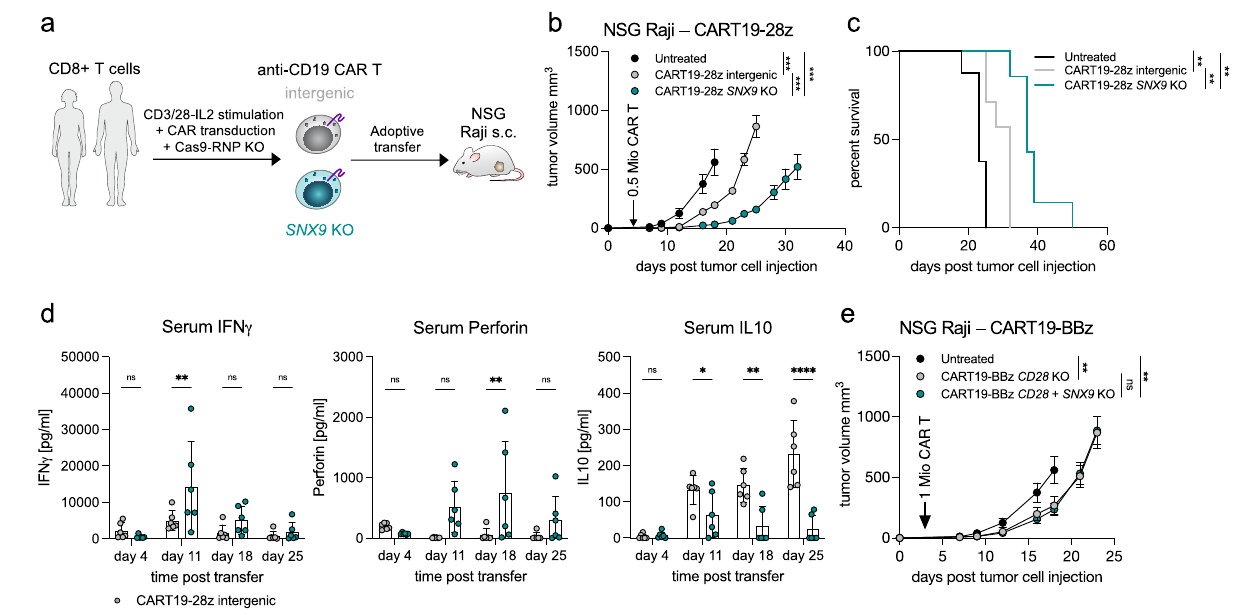
Fig. 5 | Deletion of SNX9 improves CAR T cell anti-tumor ef fi cacy. a Schematic representation of the CAR T cell transfer experiments. Healthy donor human CD8 T cells are stimulated ex vivo and lentivirally transduced with an anti-human- CD19(FMC63vH)-CD28-CD3zeta-T2A-copGFP CAR construct and electroporated with Cas9-crRNA-tracrRNA complexes to generate SNX9 KO cells and intergenic controls. These cells are then transferred to NSG mice with subcutaneous Raji tumors (CD19+). b Tumor volume in mm 3 of NSG mice treated 3 days post Raji tumor injection by i.v. transfer of 0.5 Mio human CD8 anti-CD19-28z CAR T cells with or without SNX9 KO (mean and SEM). Statistics are pairwise 2-way ANOVAs followed by Bonferroni correction. n =8 animals for untreated of n =2 experi- ments. n =7 mice for CART-treated mice of n =1 experiment. Experiment was replicated with similar results with higher CART numbers. c Survival of the NSG